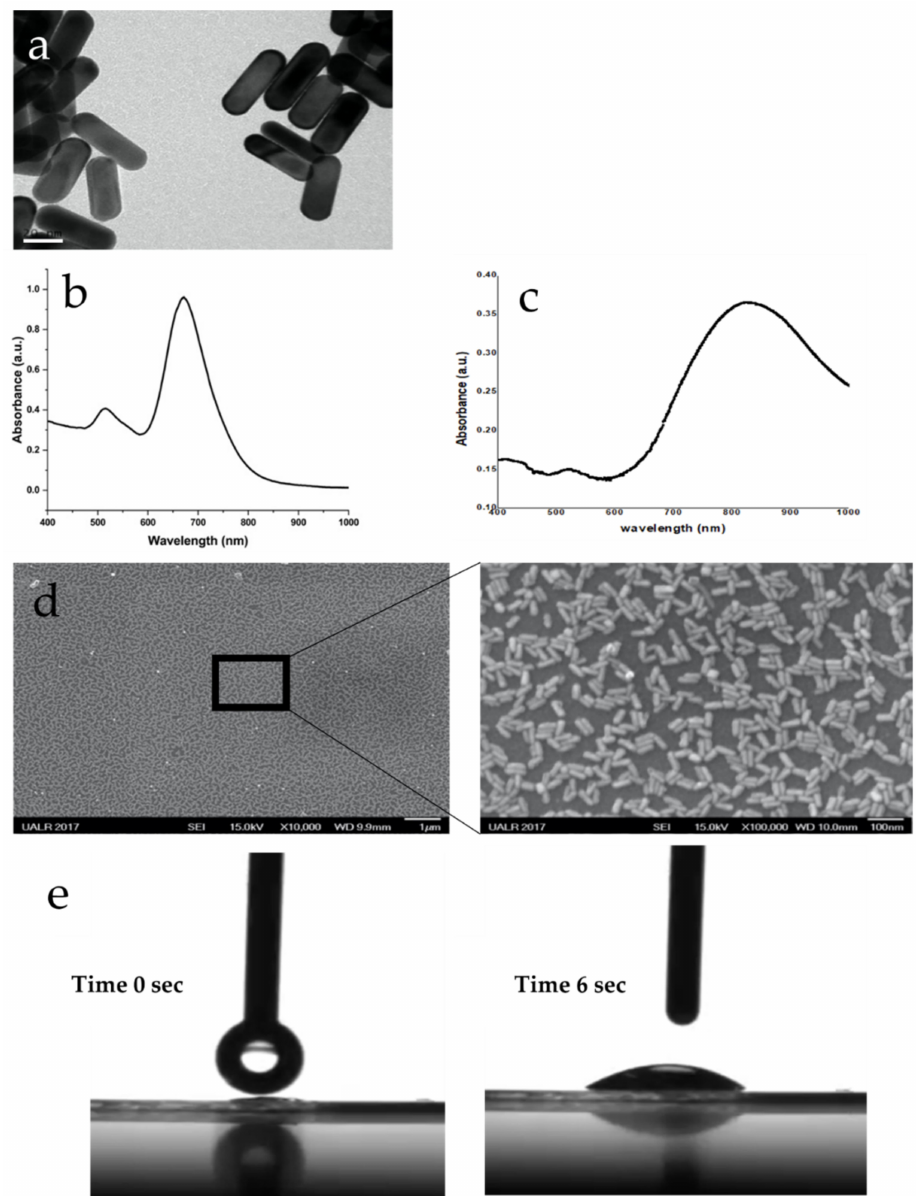
Figure 2. Characterization of fabricated AuNR substrate. ( a ) Representative TEM images of AuNRs. Scale bar: 20 nm; ( b ) representative UV-vis spectrum of AuNRs; ( c ) representative UV-vis spectrum of AuNR substrate; ( d ) representative SEM images of the glass coated with AuNRs. Scale bars: 1 µ m left panel, 100 nm right panel; ( e ) representative contact-angle measurement for the AuNR